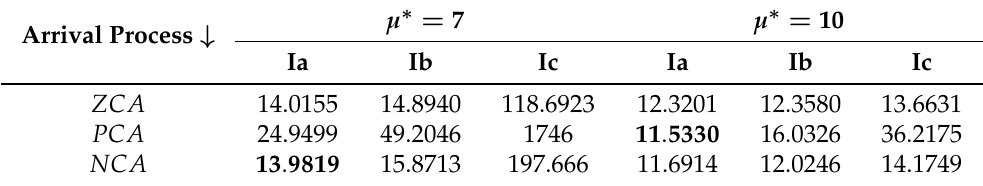
Table 16. Cost per unit time in Scenario